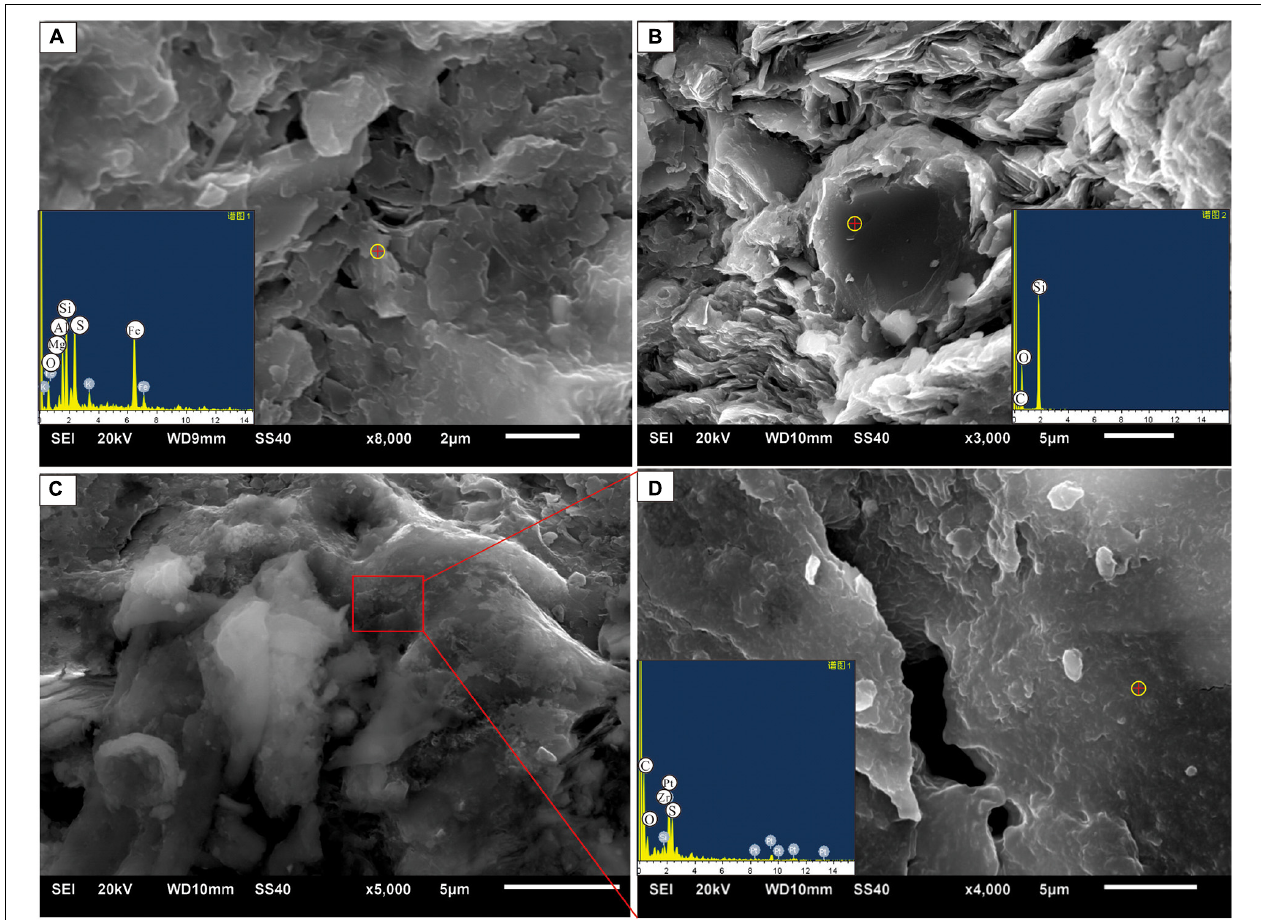
FIGURE 8 | Microscopic minerals and diagenetic characteristics of the Longmaxi Formation shale in the Sichuan Basin center (SEM and EDS). (A) An SEM image showing the clay minerals; the small picture in the lower left corner is the corresponding EDS, well JY-2, 2,459.36 m. (B) An SEM image showing authigenic quartz; the small picture in the lower right corner is the corresponding EDS, well JY-2, 2,459.36 m. (C) An SEM image showing asphalt organic matter in micro-cracks, well W-201, 2,678.61 m. (D) An SEM image that is a partial enlargement of image (C) ; the small picture in the lower left corner is the corresponding EDS.